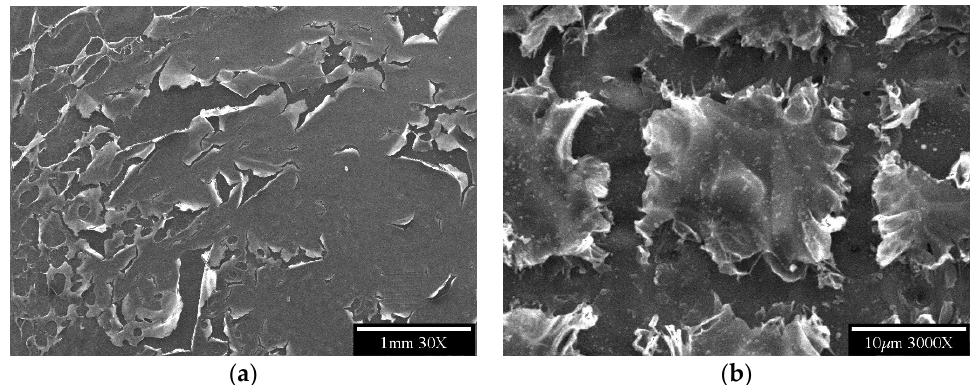
Figure 4. Lattice pattern fabricated via two-photon lithography (top view).